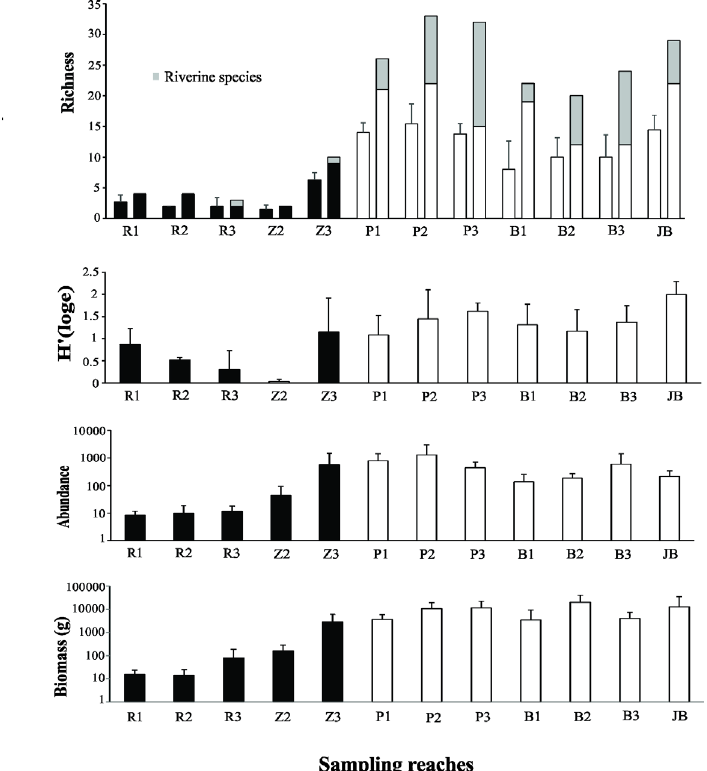
Figure 4. Mean species richness (first bar), total richness (second bar), Shannon diversity (H’), abundance and biomass, in all stream reaches of pampean streams, Buenos Aires province, Argentina. Black bars: MI reaches; white bars: LI